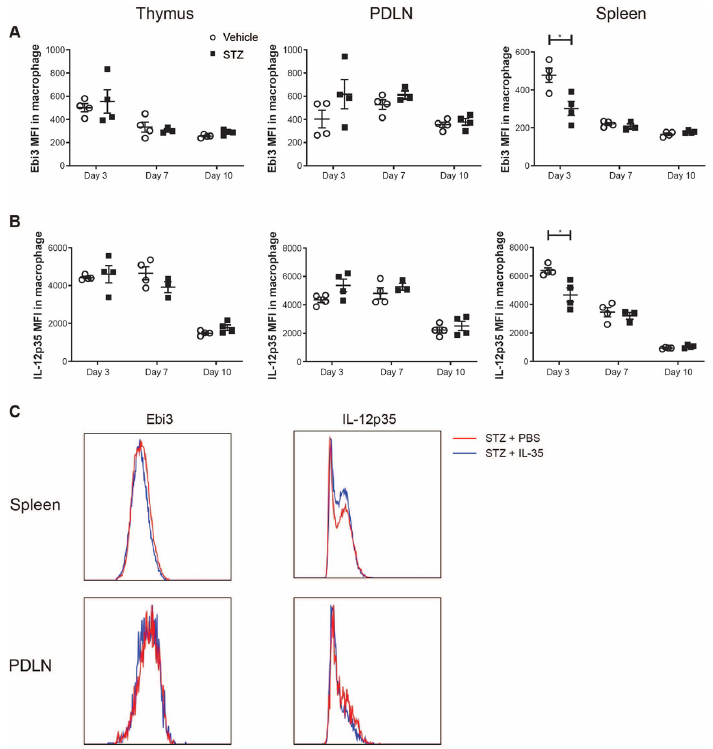
Figure 6. Mean fluorescence intensity (MFI) of Ebi3 and IL-12p35 in macrophages. Male CD-1 mice were injected intraperitoneally with low doses of STZ (40 mg/kg body weight) or saline for 5 consecutive days and were killed on days 3, 7 and 10 after the first injection. ( A , B ) The MFI of Ebi3 and IL-12p35 in macrophages in the thymus, PDLN and spleen. STZ mice received IL-35 (0.75 µ g per day) and PBS injections for 8 days and were killed on day 14. ( C ) The representative histogram of fluorescence intensity of Ebi3 and IL-12p35 in macrophages in the spleen and PDLN. Results are expressed as means ± SEM. Unpaired t -tests were performed for comparisons. * denotes p < 0.05. Next, we sorted CD11b + F4/80 + macrophages to investigate the direct effect of IL-35 on macrophages. CD11b + F4/80 + macrophages were treated with or without recombinant IL ‐ 35 (10ng/mL) overnight. IL ‐ 35 ‐ treated macrophages had lowered proportions of M1 (TNF ‐ + or MHC ‐ II + cells among macrophages) and a higher proportion of M2 (Arg1 + cells among macrophages) macrophages (Figure 7A–C). Together, these data demonstrate that the effect of IL ‐ 35 is direct on macrophages in lowering the M1/M2 ratio.